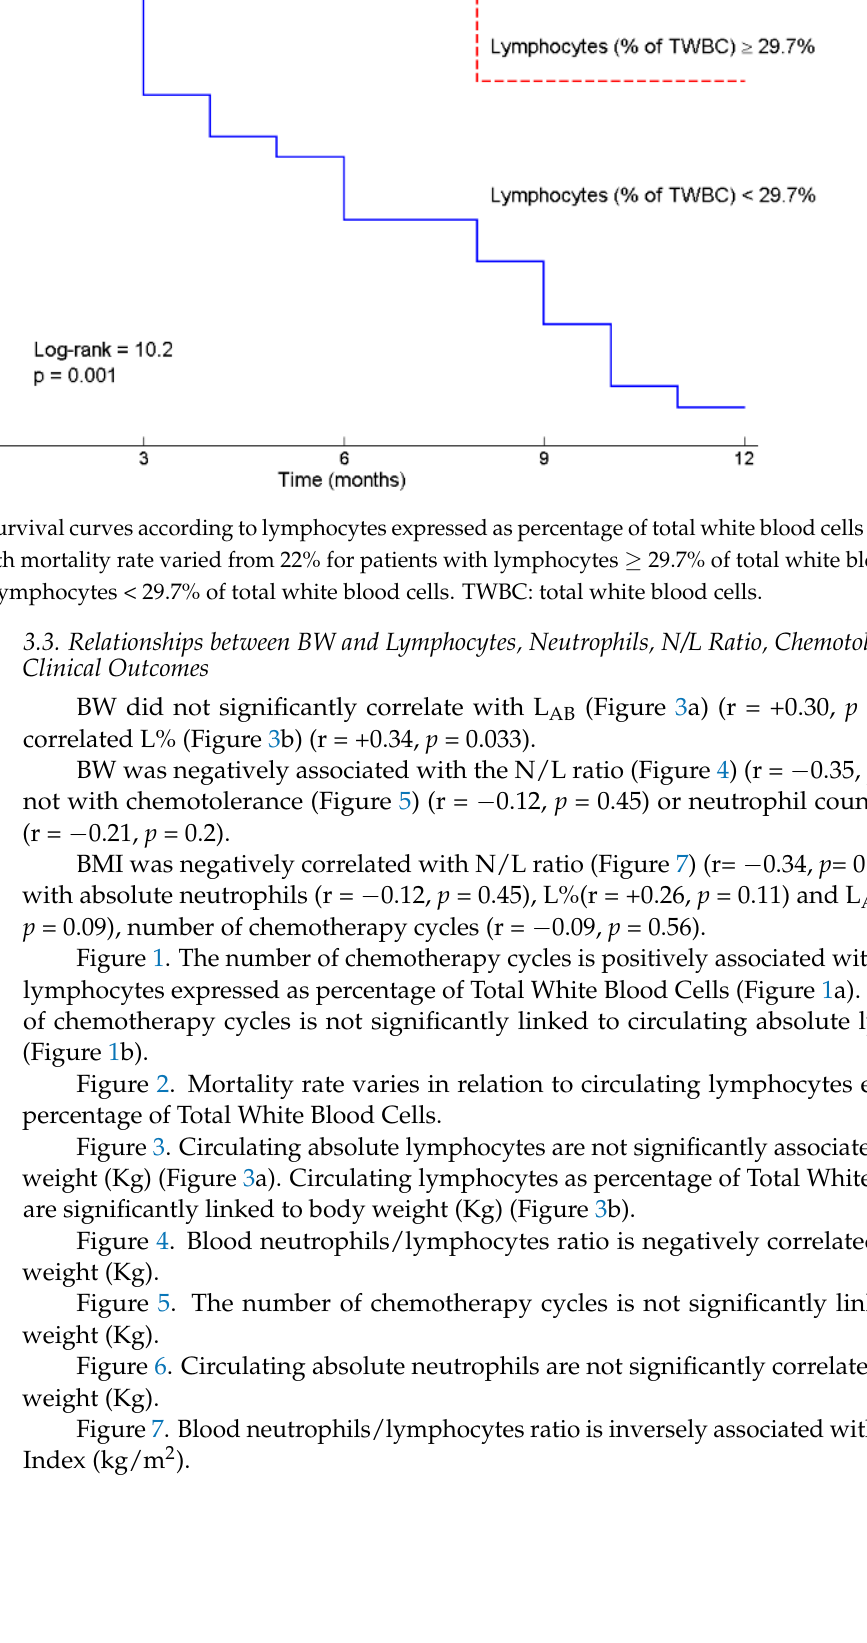
Figure 1. Scatter plots of the number of chemotherapy cycles (y axis) as a function of circulating lymphocytes (x axis) expressed as percentage of total white blood cells ( a ) and as absolute value ( b ). The value of Pearson’s correlation coeffi- cient and corresponding p value are also reported. TWBC: total white blood cells. Figure 2. Mortality rate varies in relation to circulating lymphocytes expressed as percentage of Total White Blood Cells.